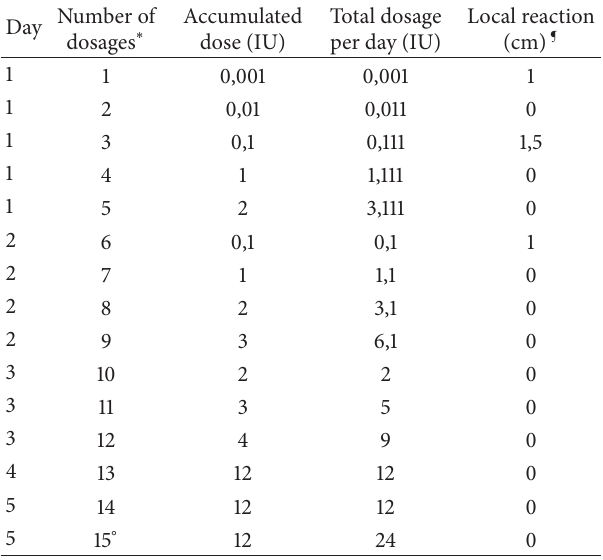
Table 4: Desensitization protocol using Glargine